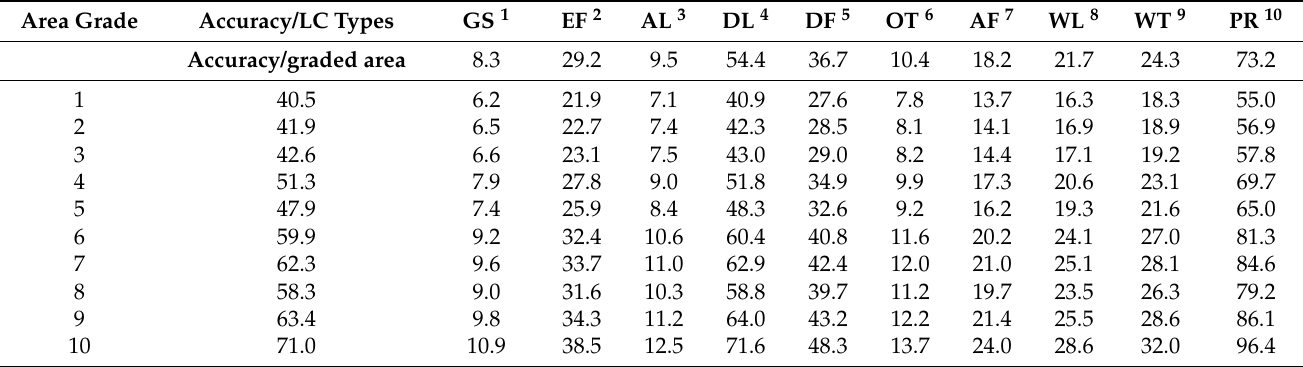
Table 1. Graded area’s global accuracy of MODIS data.